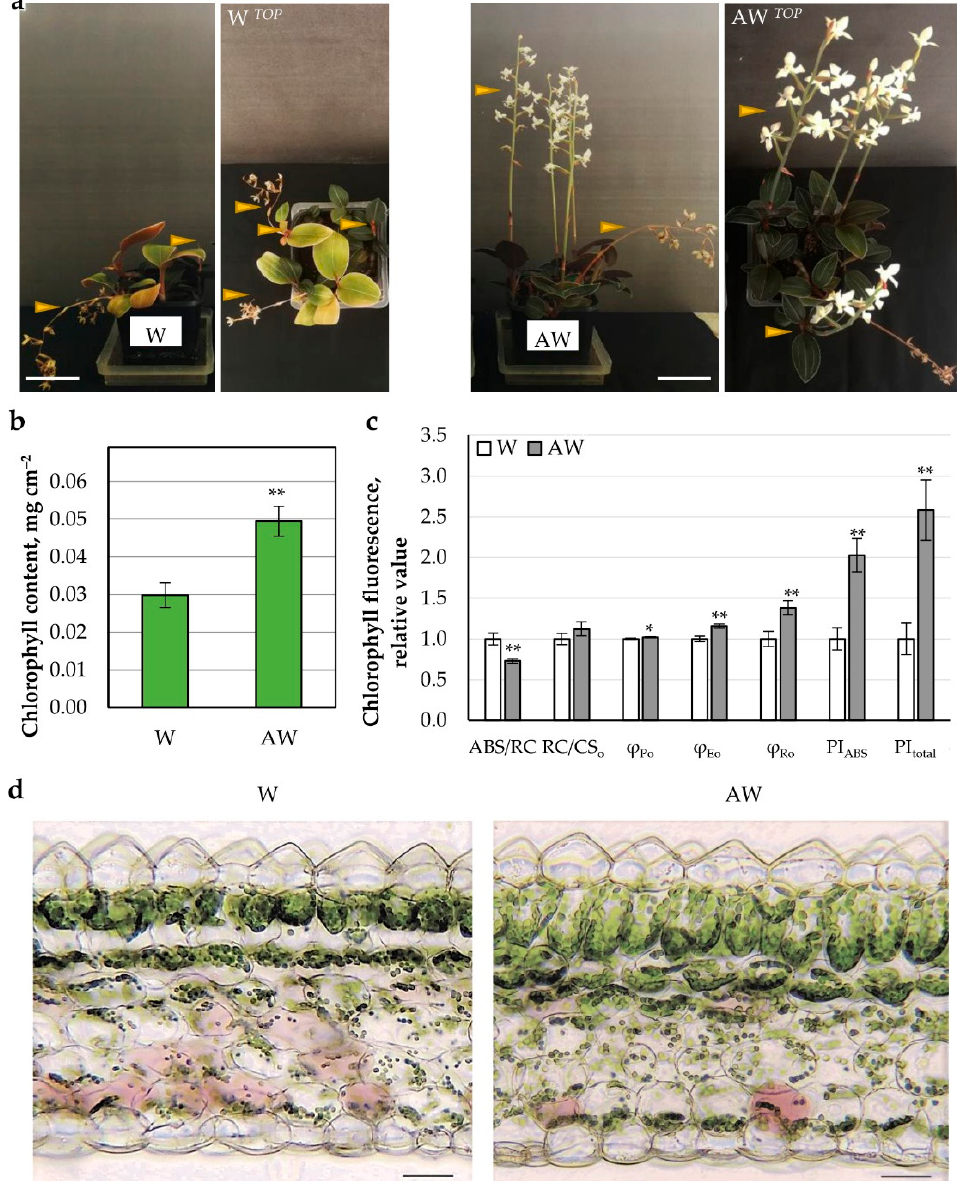
Figure 3. Growth of L. discolor in soil under treatments with AW. The plants were cultivated 2 months as hydroponic cultures and transferred in soil for 10 months. ( a ) Photo of the variants: W—water; AW—aquaponics water; Scale bar: 5 cm. Arrowheads point to flower formation. ( b ) Chlorophyll content. ( c ) Chlorophyll fluorescence parameters. ( d ) Leaf anatomical structure of L. discolor (transverse sections were made from developed leaves); Scale bar: 50 µm. Statistically significant differences compared with the control W are shown with asterisks after application of Student’s t -test (* p ≤ 0.05; ** p ≤